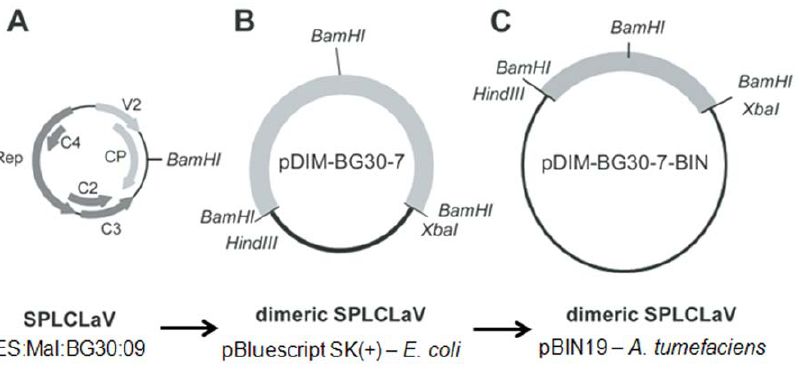
Figure 1. Strategy to generate the infectious dimeric clone of SPLCLaV, pDIM-BG30-7-BIN. (A) Genetic map of SPLCLaV, isolate ES:Mal:BG30:09, showing the Bam HI restriction site used to generate a tandem dimeric clone after partial digestion of the RCA product obtained from an infected plant. (B) Dimeric SPLCLaV cloned in pBluescript SK( + ) in E. coli (pDIM-BG30-7). (C) Dimeric SPLCLaV cloned in the binary vector pBIN19 in A. tumefaciens (pDIM-BG30-7-BIN).